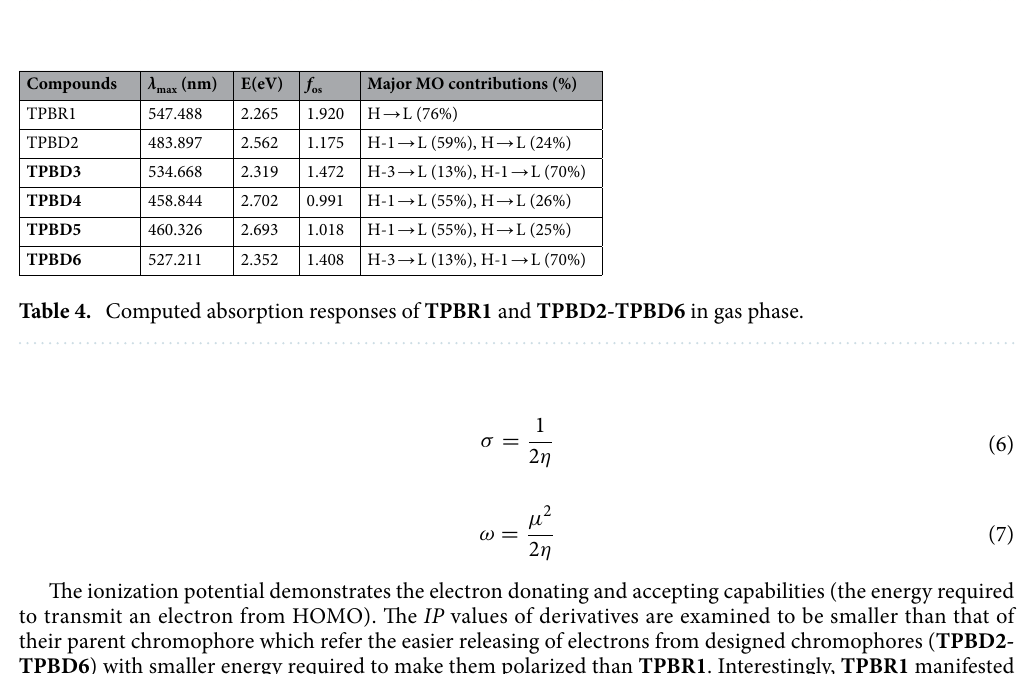
Table 3. Computed absorption responses of TPBR1 and TPBD2-TPBD6 in chloroform solvent phase.